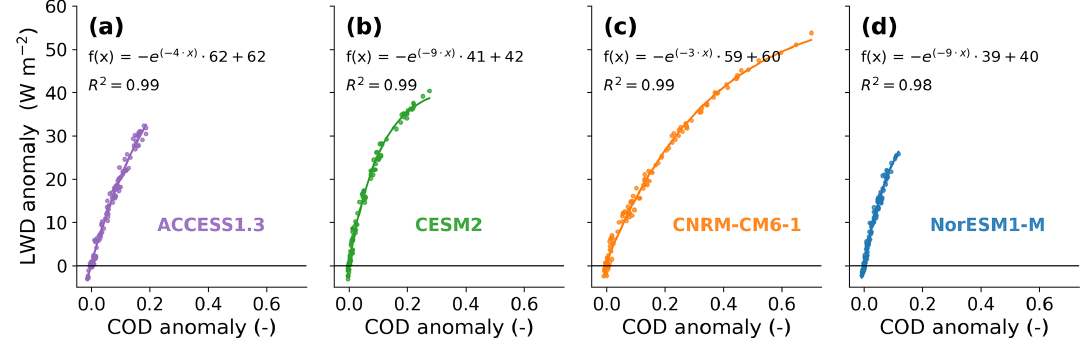
Figure 5. Summer LWD (Wm − 2 ) versus COD changes during summer (–) projected by MAR driven by ACCESS1.3 (a) , CESM2 (b) , CNRM-CM6-1 (c) , and NorESM1-M (d) compared to the summer reference period (1981–2010). The exponential regression as well as corresponding determination coefficient ( R 2 , p (cid:28) 0 . 01) is indicated for each experiment. A 10-year running mean has been applied.